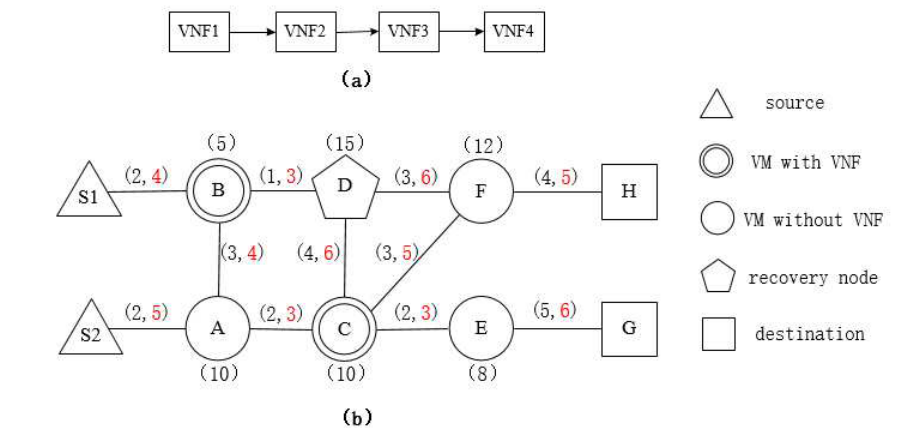
Figure 2. An example of a reliable multi-source